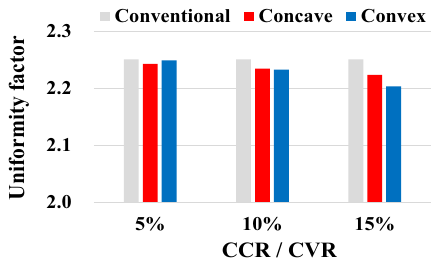
Figure 15. Uniformity of each model.